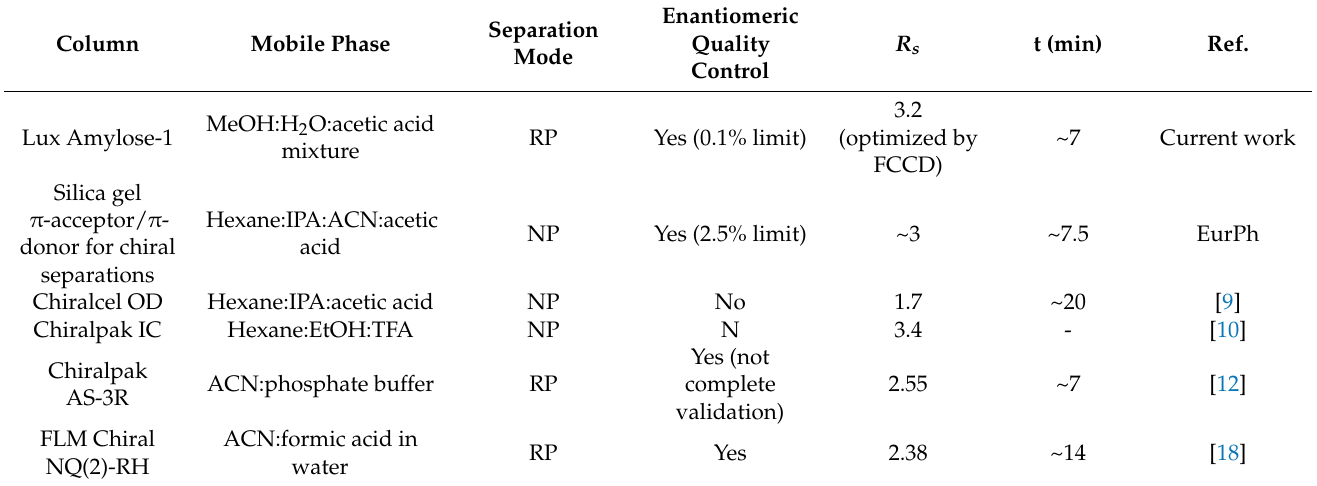
Table 4. Comparison of the current and previously described methods for the enantioseparation of